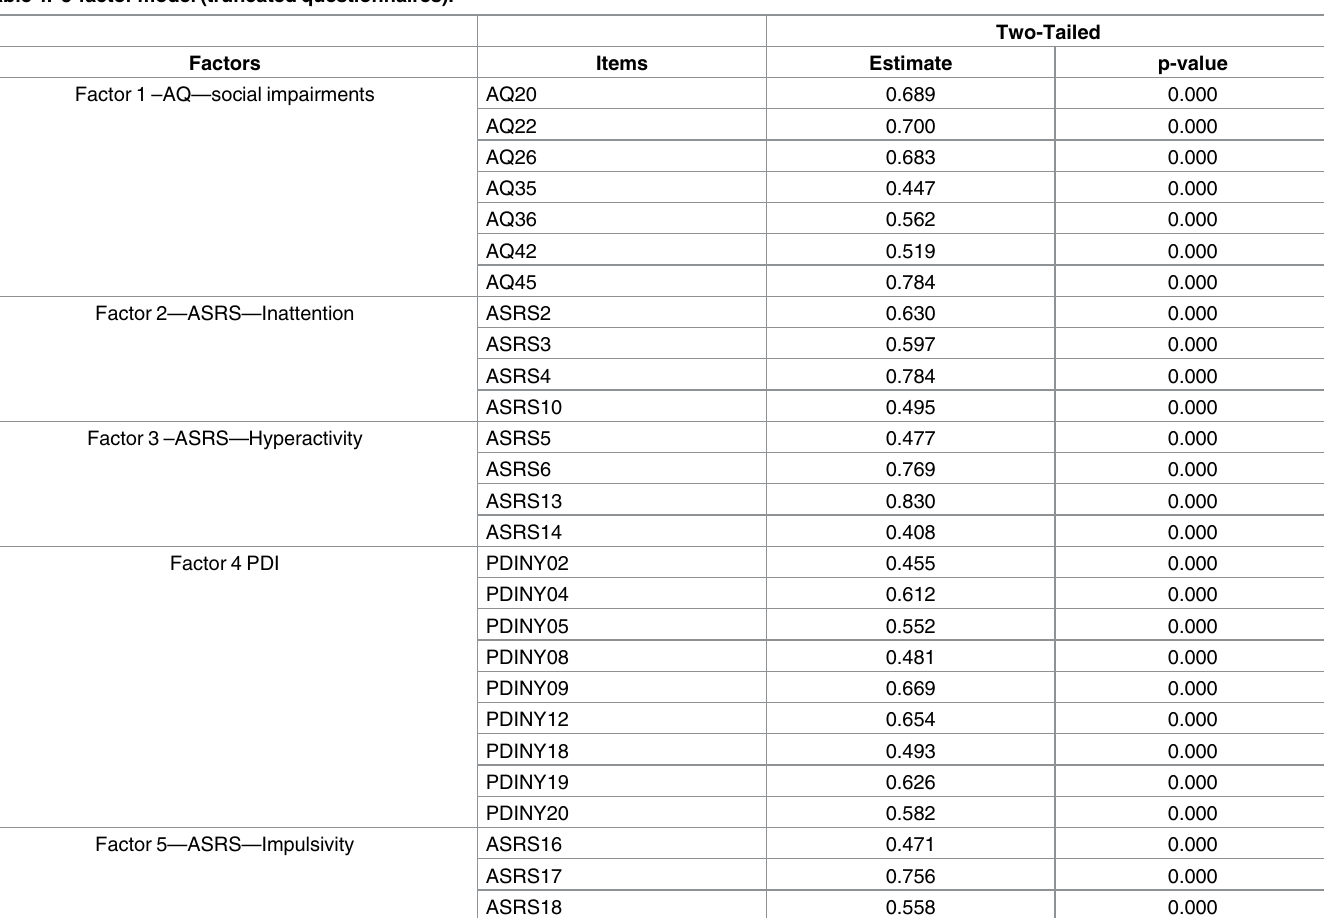
Table 4. 5-factor model (truncated questionnaires).